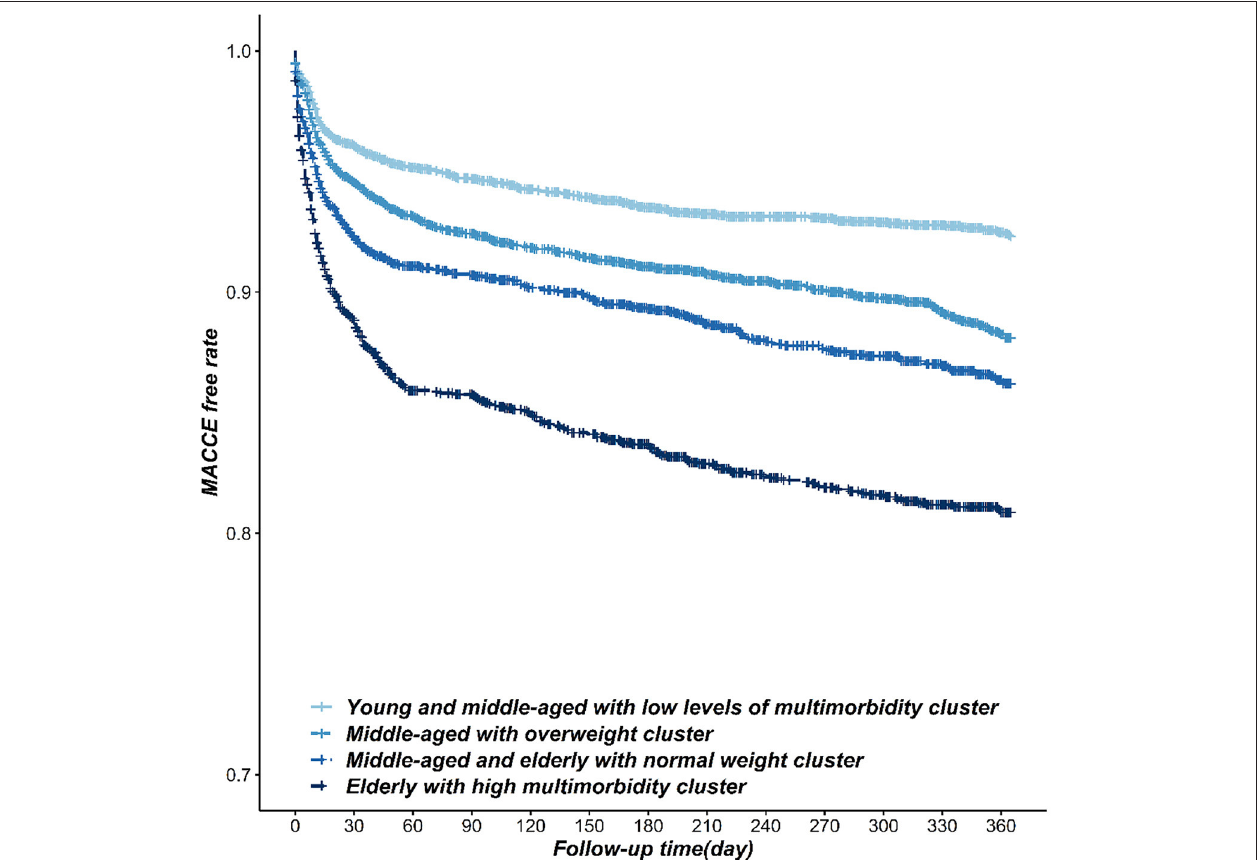
We applied LCA to identify the pattern of risk